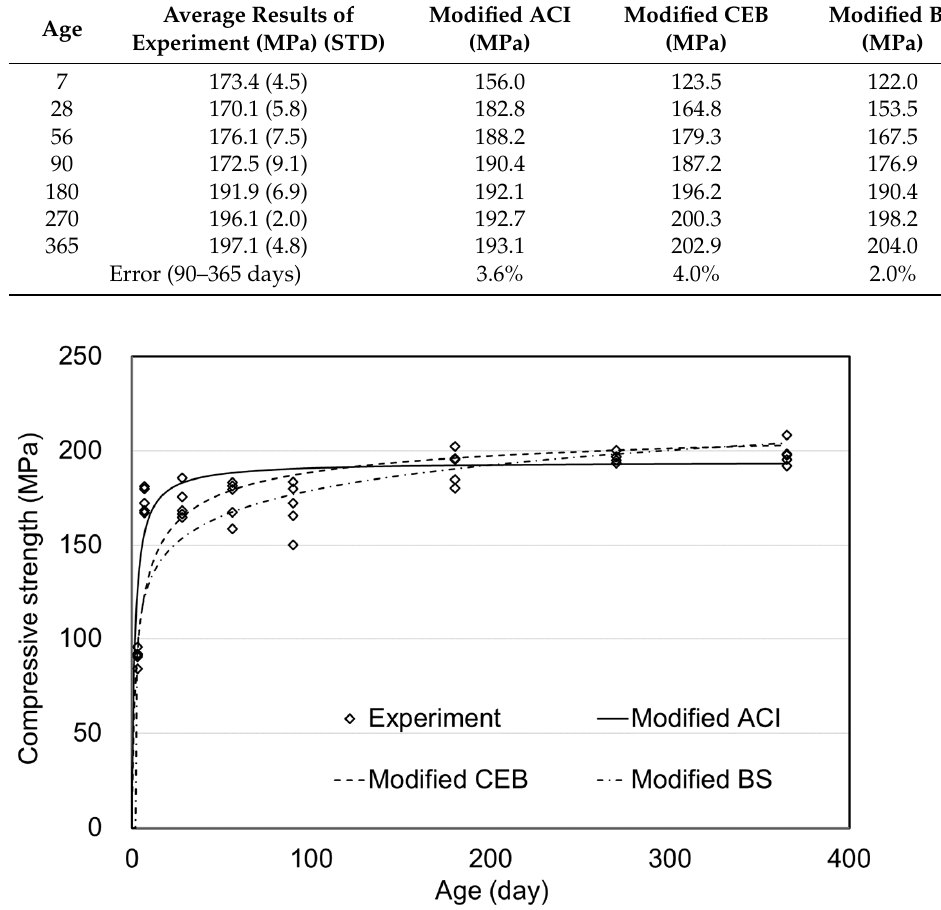
Figure 9. Prediction model of compressive strength for steam